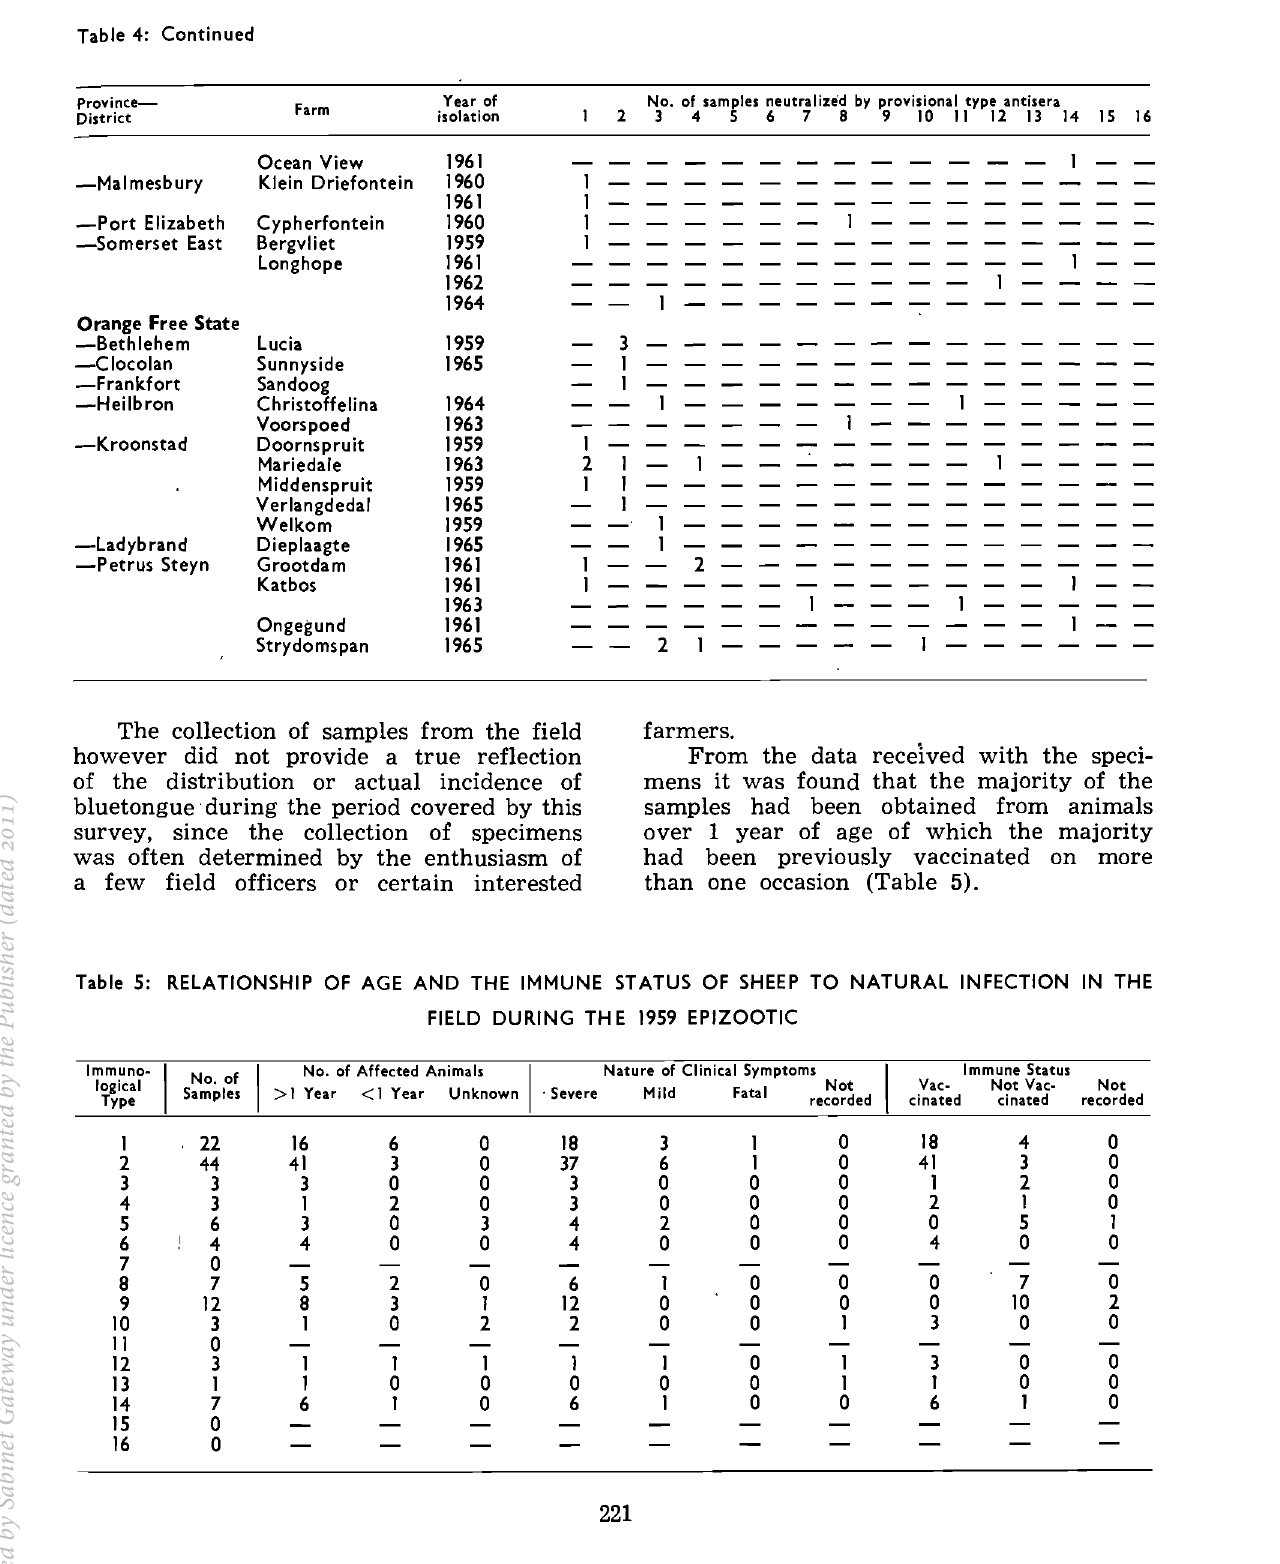
Table 5: RELATIONSHIP OF AGE AND THE IMMUNE STATUS OF SHEEP TO NATURAL INFECTION IN THE FIELD DURING TH E 1959 EPIZOOTIC Immuno- No.